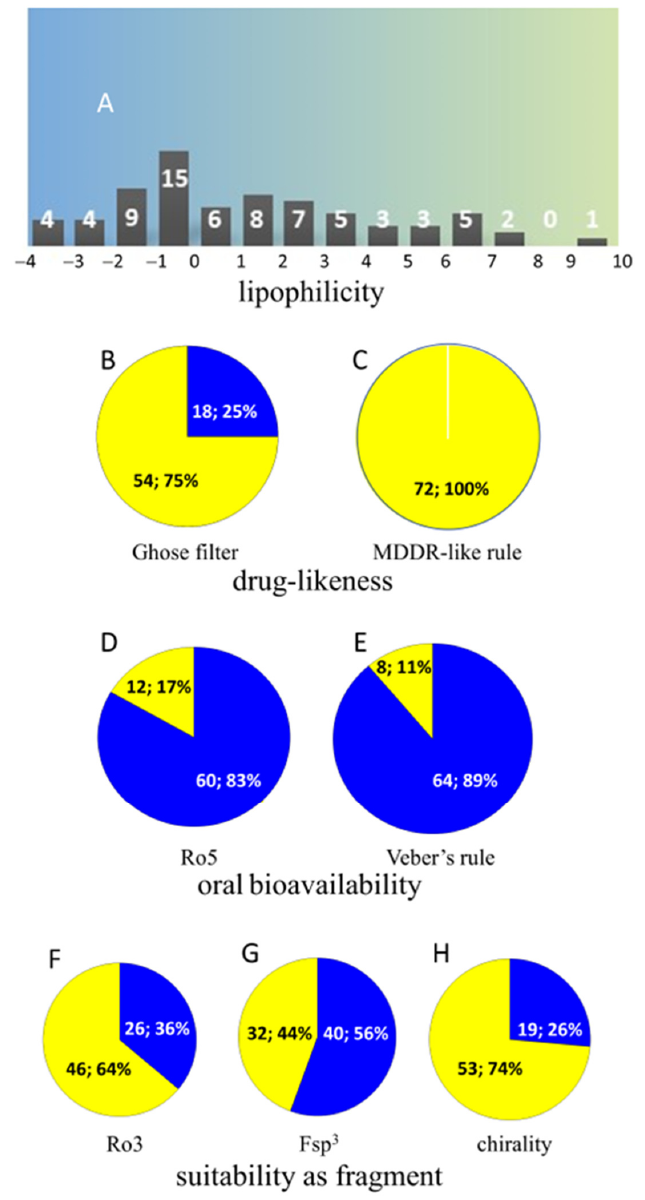
Figure 3. A: distribution of cLogP (ACD/Labs 2020.1.0) in camel urine metabolome; B: number and percentage of camel urine chemicals violating the drug-like Ghose filter [ − 0.4 < cLogP < 5.6, 160 < MW < 480, 40 < molar refractivity [89] < 130, 20 < number of atoms < 70 [90] , yellow sector]; C: number and percentage of camel urine chemicals violating the MACCS-II Drug Data Report (MDDR)-like rule [ring number (RN) ≥ 3, rigid bonds (RBs) ≥ 6, RBs ≥ 18 [89]] for drug-like compounds (yellow area); D: number and percentage of camel urine chemicals fulfilling the Rule of Five’s (Ro5) requirements [hydrogen bond donors (HBDs) ≤ 5, hydrogen bond acceptors (HBAs) ≤ 10, MW ≤ 500 Da, cLog P ≤ 5 [91]] for oral bioavailability (blue sector); E: number and percentage of camel urine chemicals fulfilling Veber’s rule [polar surface area (PSA) ≤ 140 Å2, rotatable bonds (RBs) ≤ 10, HBDs + HBAs ≤ 12 [92]] for oral bioavailability (blue sector); F: number and percentage of camel urine chemicals fulfilling the Rule of Three’s (Ro3) requirements [hydrogen bond donors (HBDs) ≤ 3, hydrogen bond acceptors (HBAs) ≤ 3, MW < 300 Da, cLog P ≤ 3 [93]] for fragments (blue sector); G: number and percentage of camel urine compounds with a fraction of sp3-hybridized carbon atoms (Fsp3) > 0.2 [94] (blue sector); H: number and percentage of chiral compounds found in camel